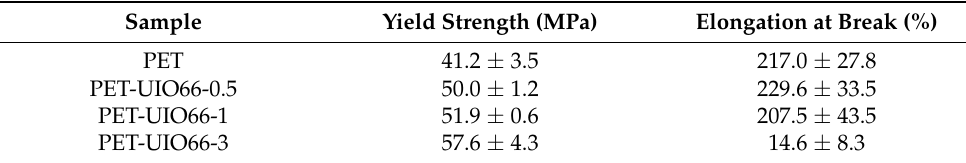
Figure 10. The stress–strain curves of PET and PET/UIO-66 nanocomposites. Table 5. Detailed tensile properties of PET and PET/UIO-66 nanocomposites.